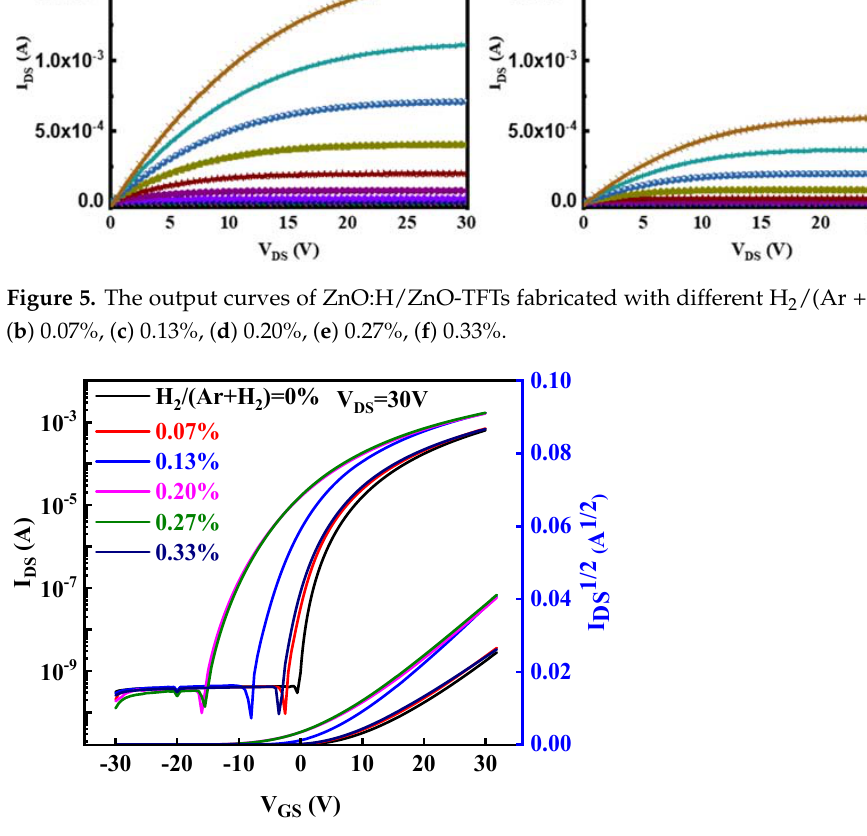
Figure 6. The transfer curves and the corresponding I DS 1/2 - V GS curves of ZnO:H/ZnO-TFTs fabricated with different H 2 /(Ar + H 2 ).